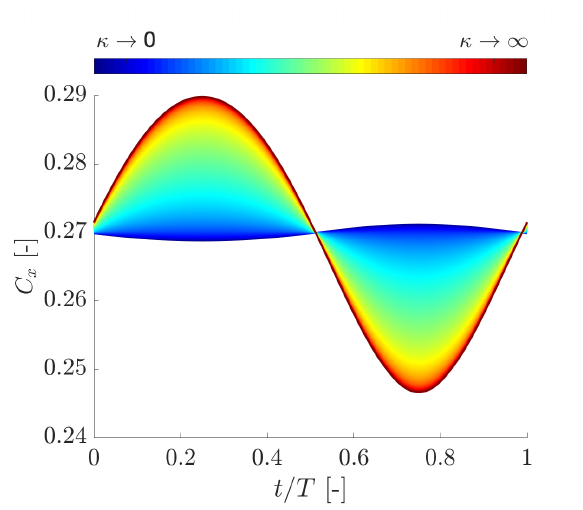
Fig. 3: Sectional thrust coefficient C x over a nondimensional period of revolution t/T of a morphing blade section at 75% of the span of a 1 MW turbine operating at a tip speed ratio of 4.5 in shear flow. The colours indicate the stiffness of the spring of the morphing blade section, from rigid (dark red) to flexible (dark